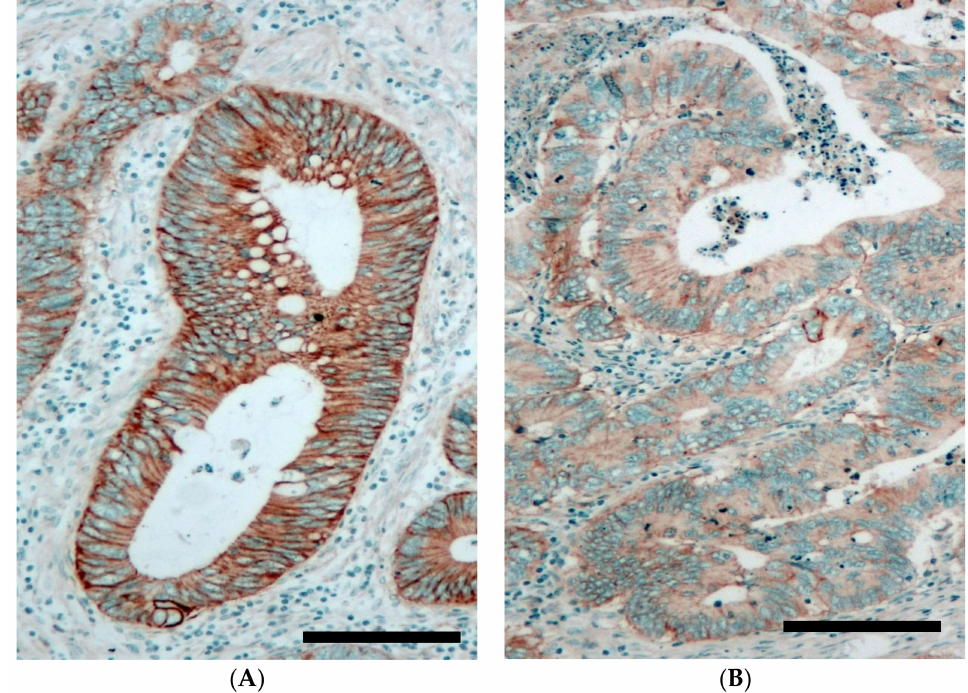
Figure 1. Epidermal growth factor receptor (EGFR) protein expression of colorectal cancer tissue as detected by immunohistochemistry (brown membrane signal). ( A ): High EGFR expressing primary colorectal cancer (H-score = 248). ( B ): Low EGFR expressing primary colorectal cancer (H-score = 31). Cell nuclei are stained by hematoxilin (blue). Bar = 200 µ